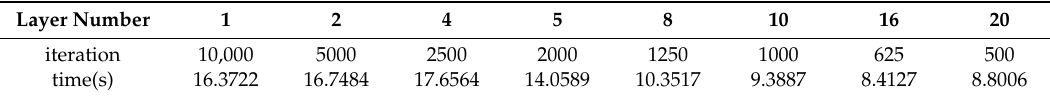
Table 3. Comparison of time-consuming process for HWSU versus the layer number.